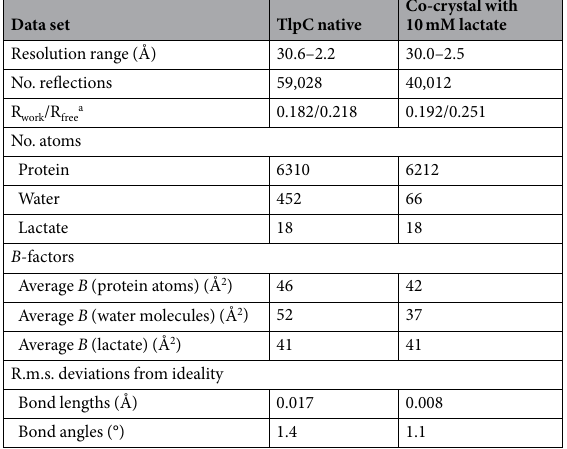
Table 3. Refinement statistics. a The R free was calculated on 5% of the data omitted at random.